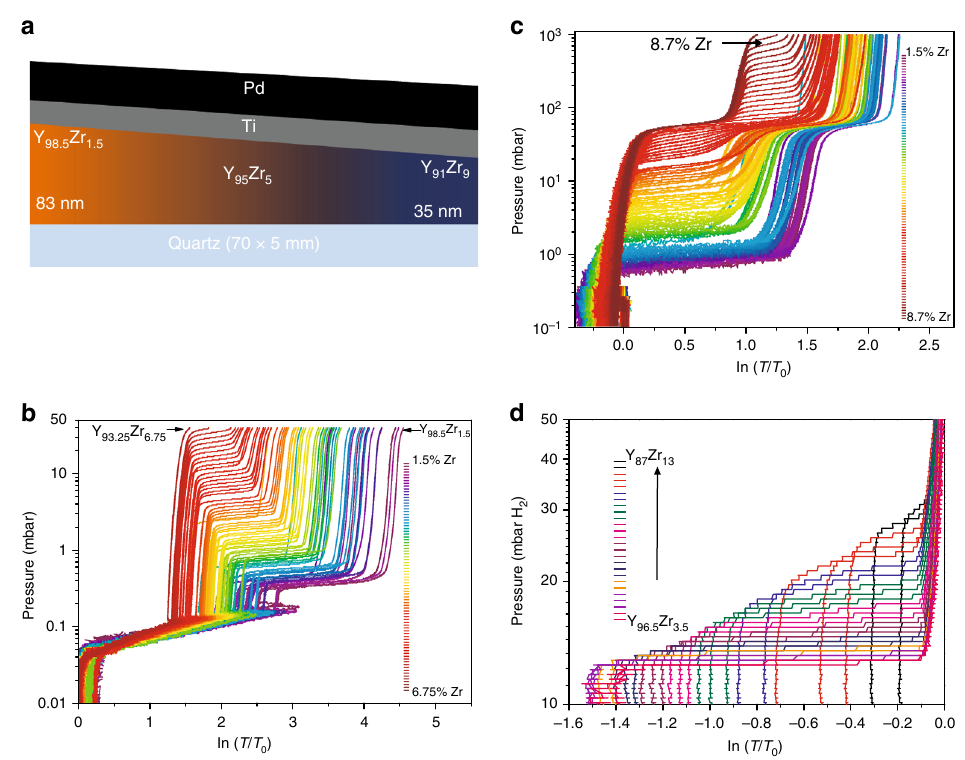
Fig. 1 The effect of Zr on the hydrogenation pressure of Y. a Schematic picture of the Y – Zr compositional gradient resulting in a wedge geometry with a thickness ranging from ~38 to 80 nm on a 70 × 5 cm quartz substrate, topped by a 5 nm Ti and 30 nm Pd cap layer. b Pressure transmission isotherms (PTIs) during the fi rst hydrogen absorption cycle (0 – 40 mbar H 2 at 25 °C). It shows the PTIs of 73 different Zr concentrations measured simultaneously in the thin fi lm compositional gradient. Clearly, the pressure at which the YH 2.1 → YH 3 transition occurs depends on the Zr concentration. Each line in the graph represents a 0.015 at.% increase in Zr, starting from 1.5% Zr, i.e., Y 98.5 Zr 1.5 . c PTIs of the sample during the sixth hydrogen absorption cycle at 25 °C, starting from the dihydride state. d Desorption isotherm (PTIs) at 220 °C for selected Zr concentrations (Y 96.6 Zr 3.4 – Y 85 . 5 Zr 14.5 ). Each isotherm represents a 0.38 at. % increase in Zr, starting from 3.5% Zr. Note that before dehydrogenation, the sample was fi rst exposed to 10 4 mbar (10 bar) H 2 . The steps in pressure are due to due to the logarithmic decrease in hydrogen pressure from 10 4 to 1 Supplementary Fig. 5. To our knowledge, such a strong effect of doping on the plateau pressure has never been observed before.